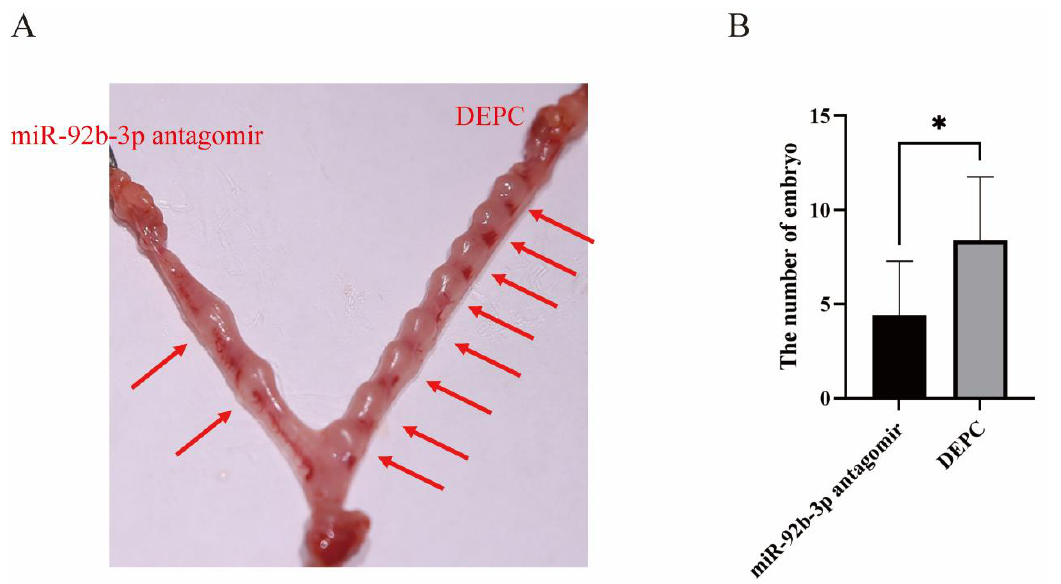
Figure 6. The function of miR-92b-3p in the mouse embryo attachment process. ( A , B ) Compar- ison of the number of implantation sites in mice injected with miR-92b-3p antagomir in one uterine horn (left side) and DEPC water in the other uterine horn (right side). The statistical significance of differences between means was assessed using paired t -tests (* p < 0.05).